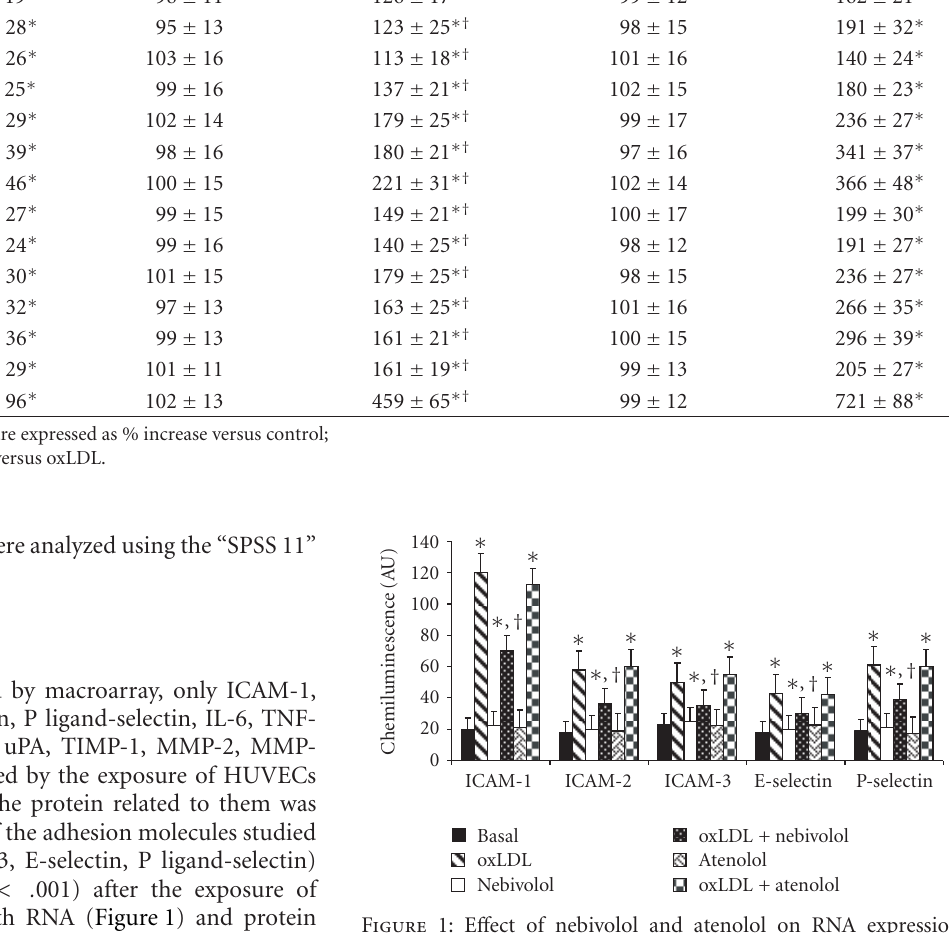
Table 1: E ff ect of nebivolol and atenolol on protein expression of adhesion molecules (ICAM-1, ICAM-2, ICAM-3, E-selectin, P-selectin), proteins linked to inflammation (IL-6, TNFalpha), and thrombotic state (tissue factor, uPA, PAI-1), endothelin-1 (ET-1), metalloproteinases (MMP-2, MMP-9), and protease inhibitor (TIMP-1) induced by oxidative stress in endothelial cells. oxLDL